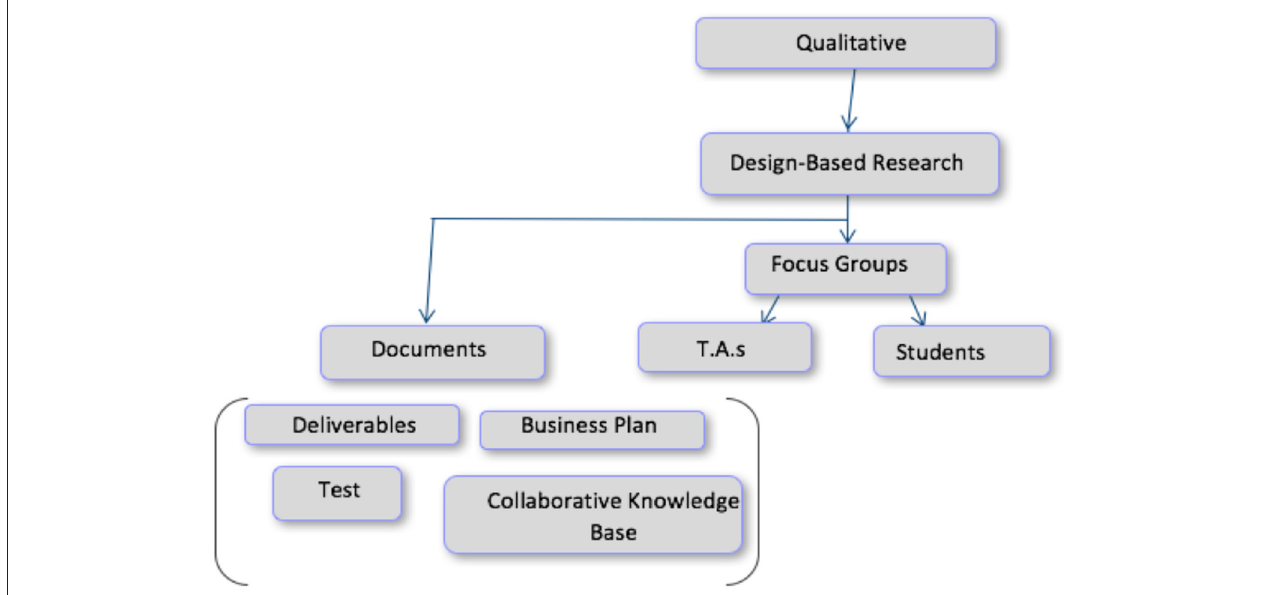
FIGURE 3 | Flow chart of methodology and data